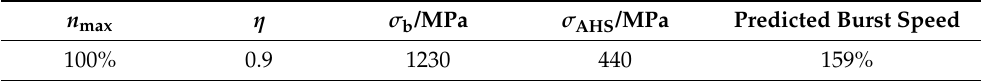
Table 6. Prediction of burst speed based on the average hoop stress